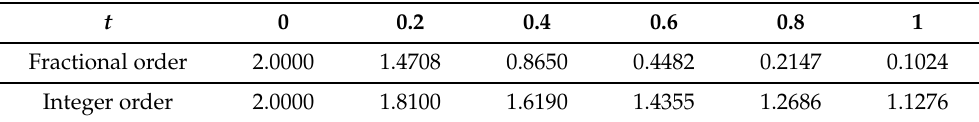
Figure 4. Simulation of solutions of the integer-order equation corresponding to Example 2. Table 2. Comparison of numerical solutions of u ( t ) in Example 2.